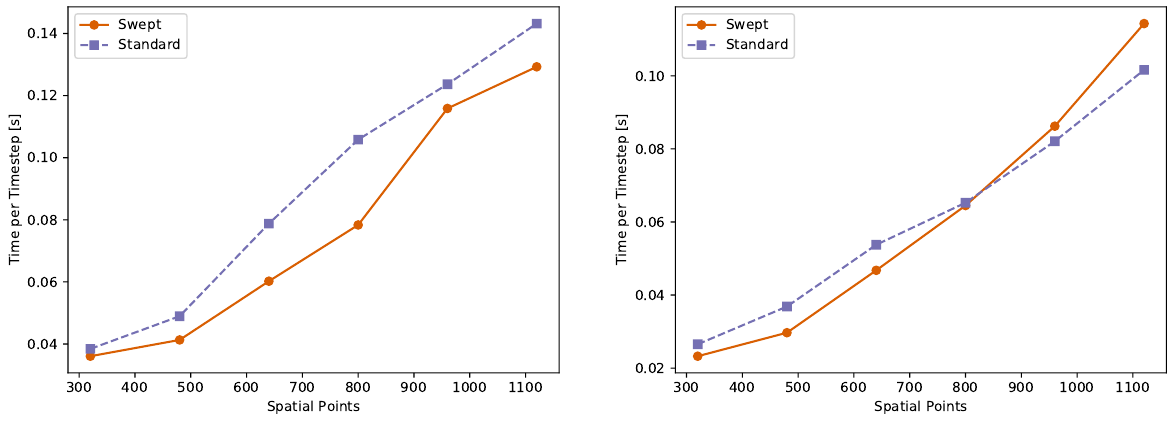
Figure 7. Time-per-timestep optimal performance for a given array size with a share of 100% solving the heat